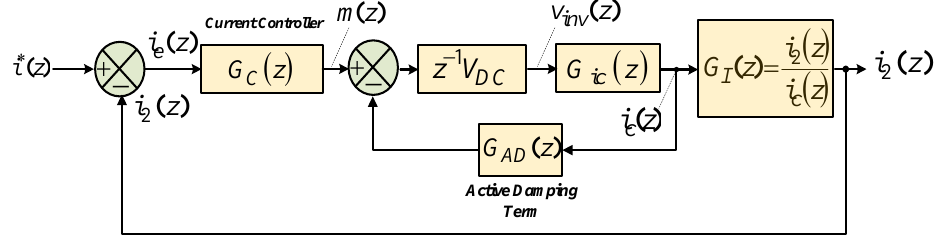
Figure 18. Z -domain block diagram of the first-order HPF-based CCF AD scheme.